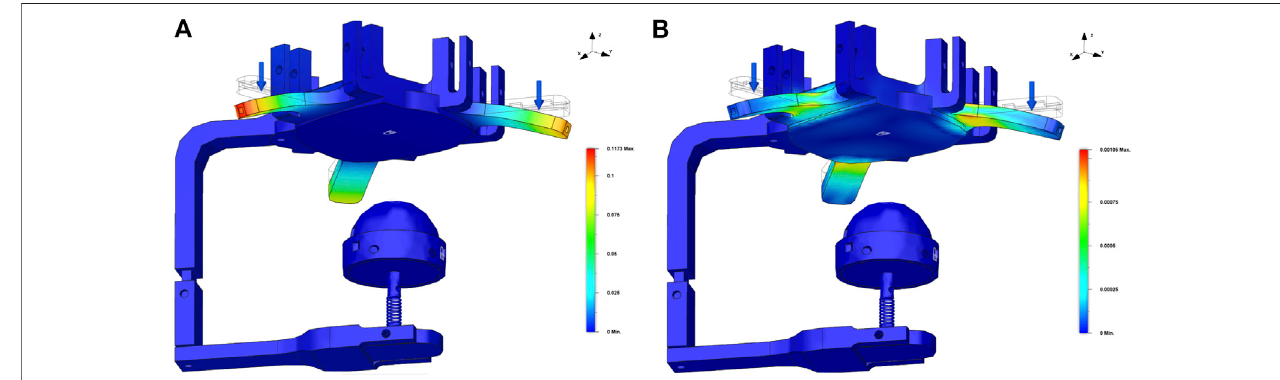
FIGURE 7 | Results of the FEM analysis for the platform of the back of the hand under the action of an overall 15 N force (5 N for each side of the “ Y-shape ” ). Blue arrows indicate the forces applied while the transparent wireframe, the CAD model, is the reference undeformed model, while the colored surface corresponds to a 1X deformation of the haptic palm device. Sub fi gure (A) shows the displacement of the platform and the sub fi gure (B) reports the deformation of the platform.